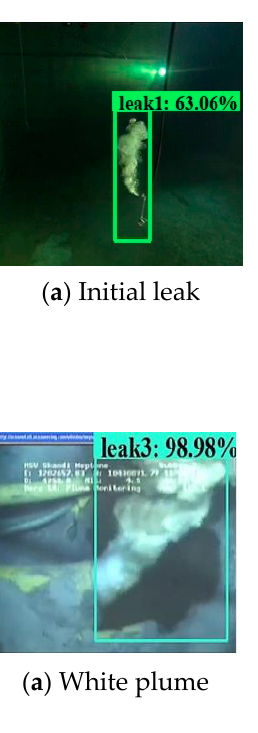
Figure 17. Comparison regarding ROC curve and AUC value between the Faster R-CNN model developed by the experimental dataset with image size 1280 × 720 and noise intensity 0, and the YOLOv4 model developed by the experimental dataset with image size 480 × 480 and noise intensity 0.